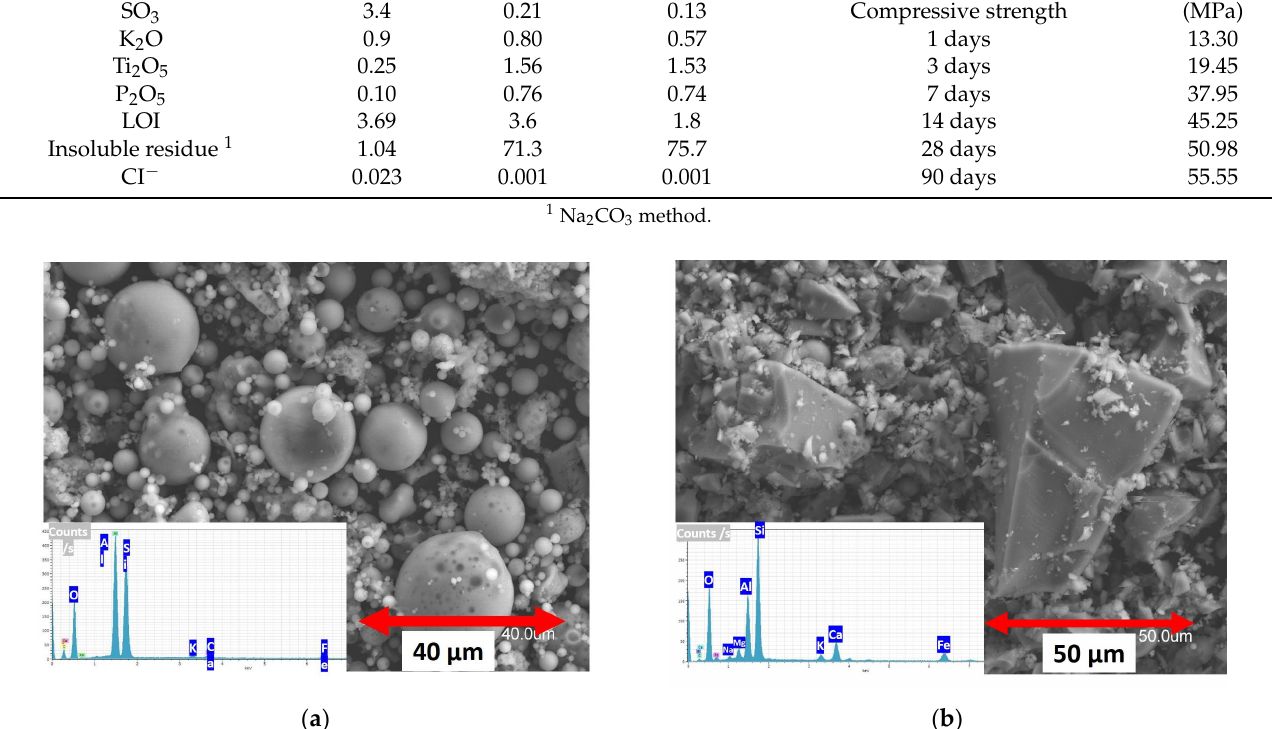
Figure 2. Scanning electron micrograph and EDS microanalysis: ( a ) coal fly ash; ( b ) ground coal bottom ash.